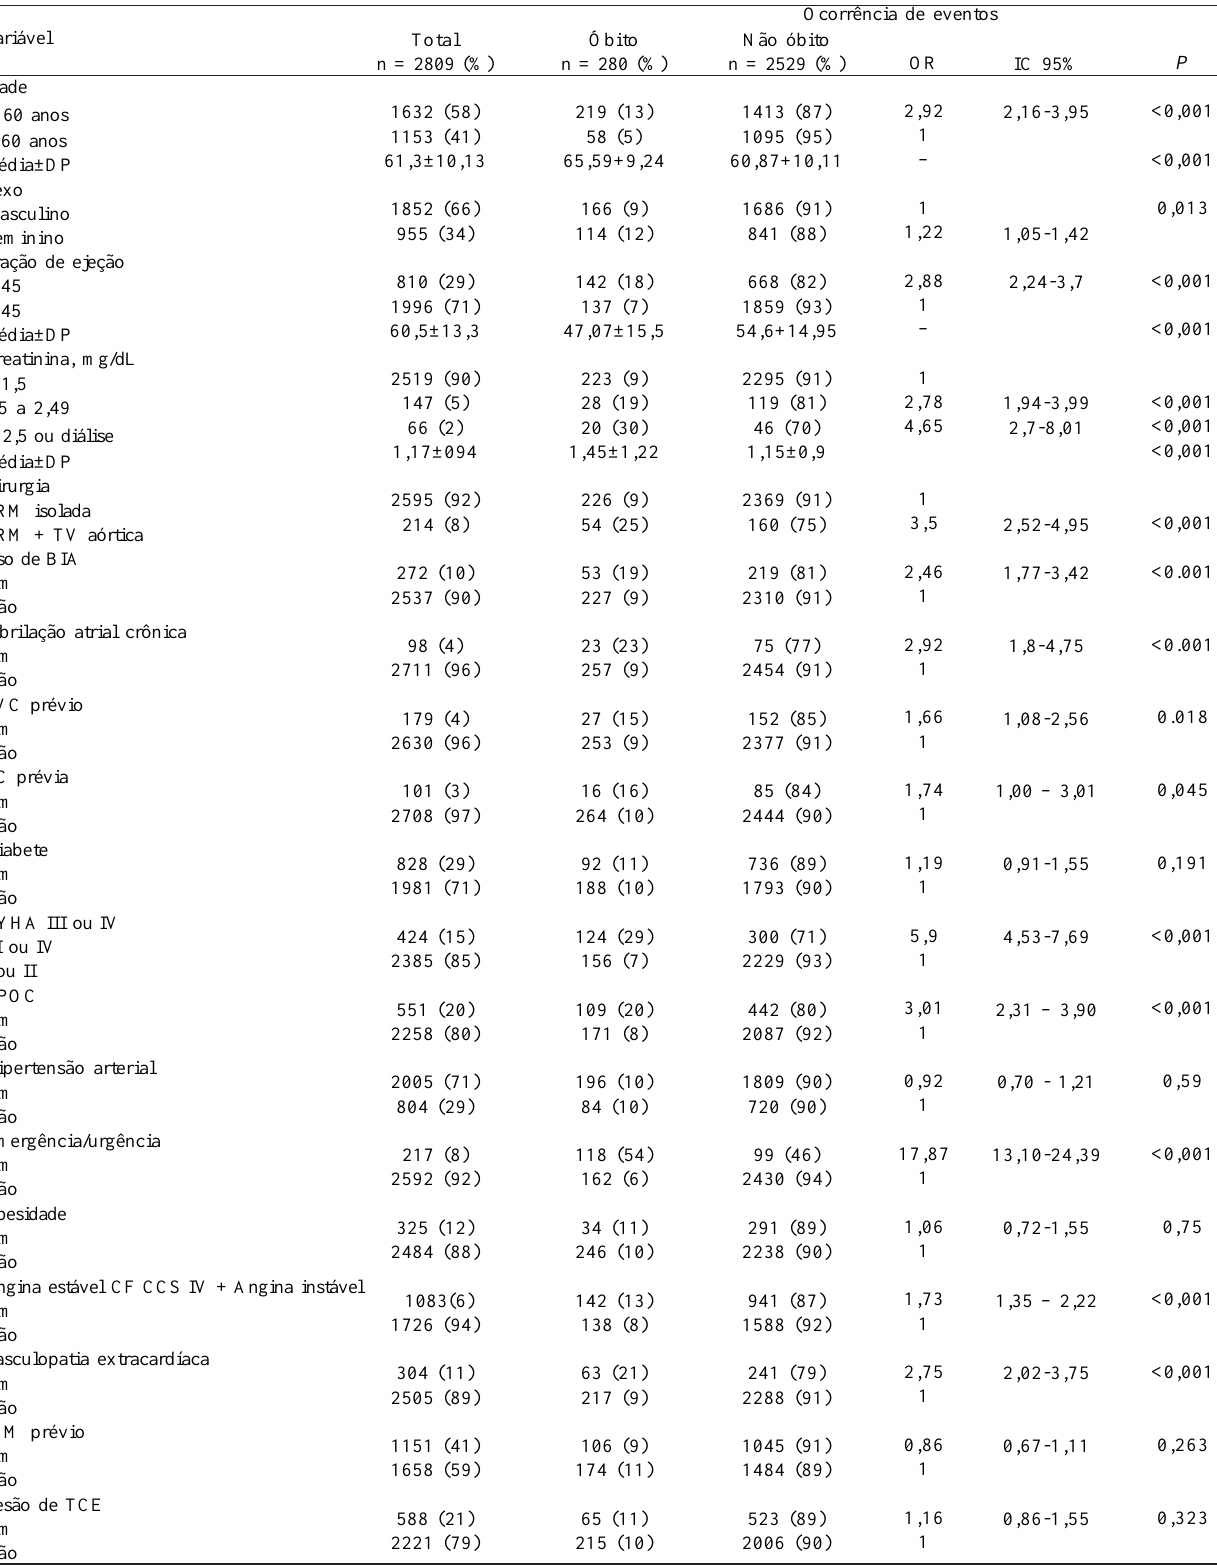
Tabela 1. Característica dos grupos estudados e análise univariada.